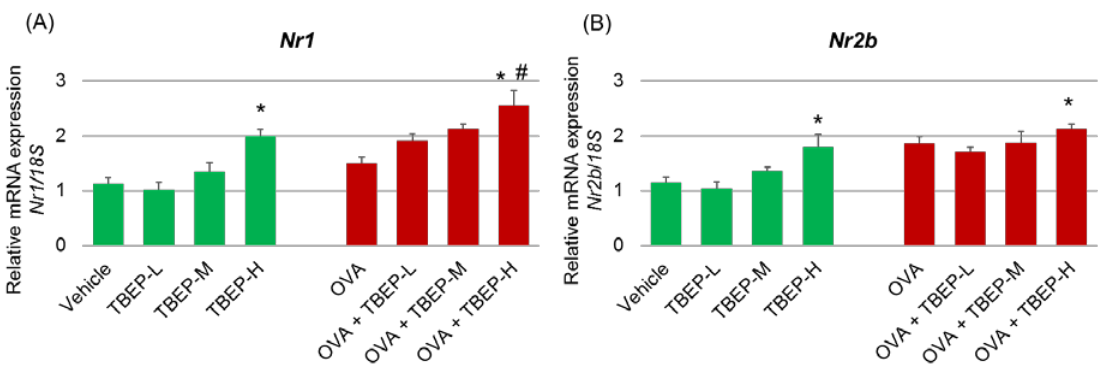
Figure 3. Messenger RNA expression levels of memory function-related genes Nmda receptor sub- units. ( A ) Nr1 and ( B ) Nr2b mRNA in the hippocampus of TBEP-exposed male mice with or without OVA immunization. (n = 6, * p < 0.05 vs. vehicle alone; # p < 0.05 vs. OVA alone).